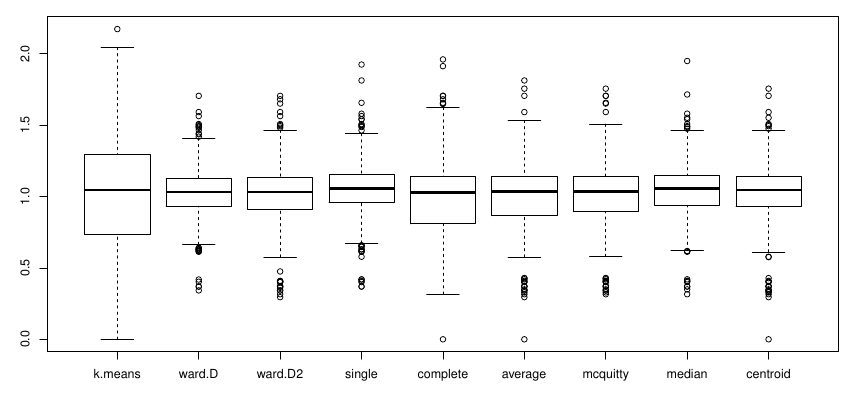
Figure 5. Box plots of simulated MEs for all hierarchical clustering methods when γ = 8.